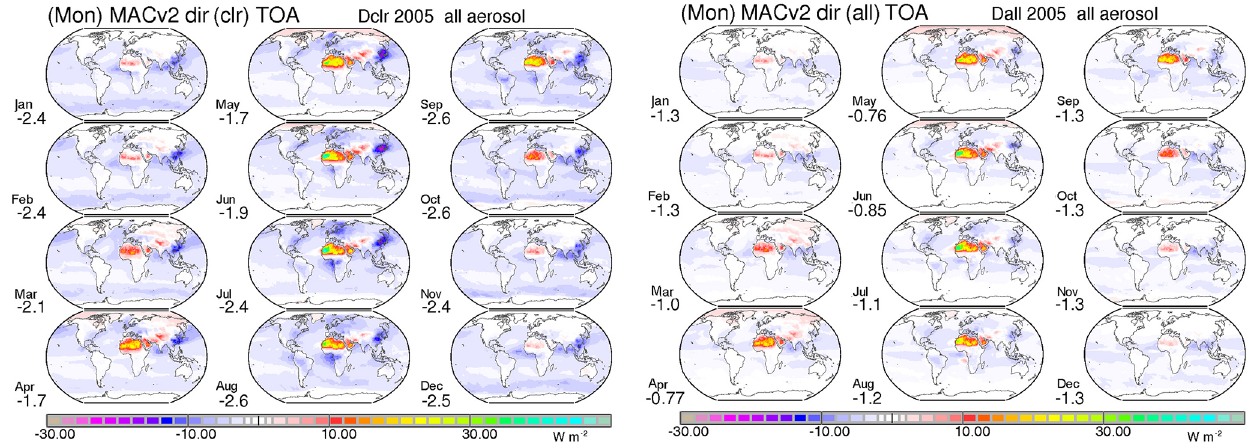
Figure C1. Monthly maps for the direct radiative forcing at the TOA by present-day total aerosol under clear-sky conditions (left frame) and all-sky conditions (right frame). Blue colors indicate climate cooling and red colors indicate climate warming. The infrared greenhouse effects by elevated coarse-mode mineral dust aerosol are included. Values below the labels indicate global